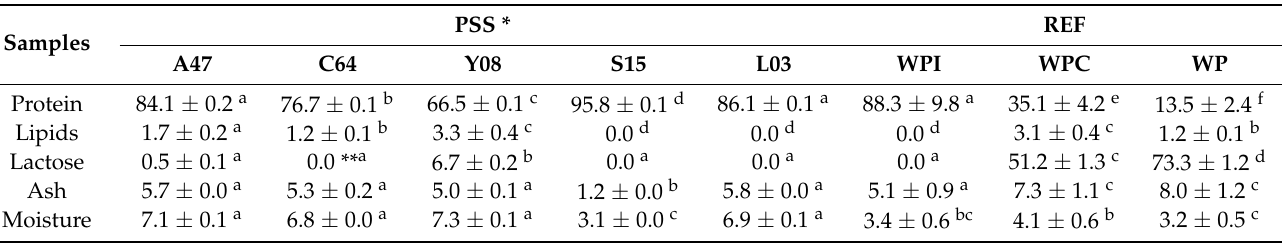
Table 1. Composition (g/100 g) of commercial samples of powdered sport supplements (PSS) and reference samples